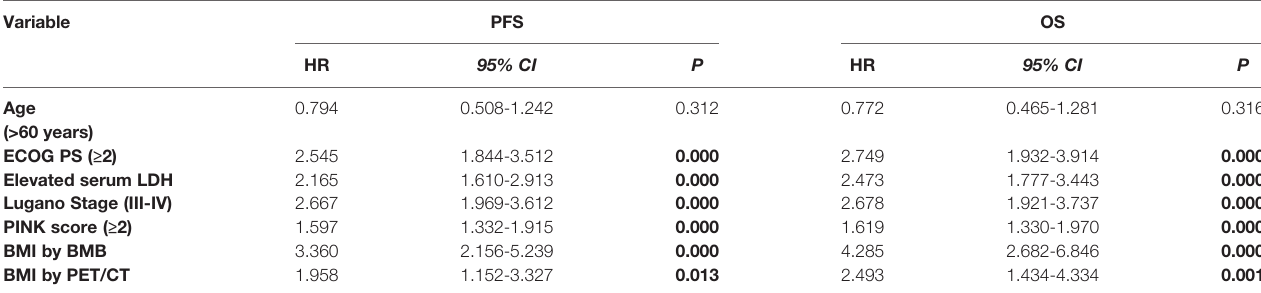
TABLE 4 | Univariate analysis of PFS and OS in 356 patients with ENKTL. Variable